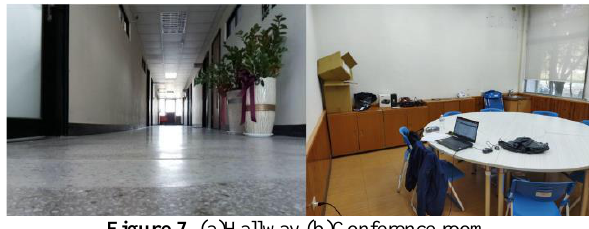
Figure 7. (a)Hallway (b)Conference room